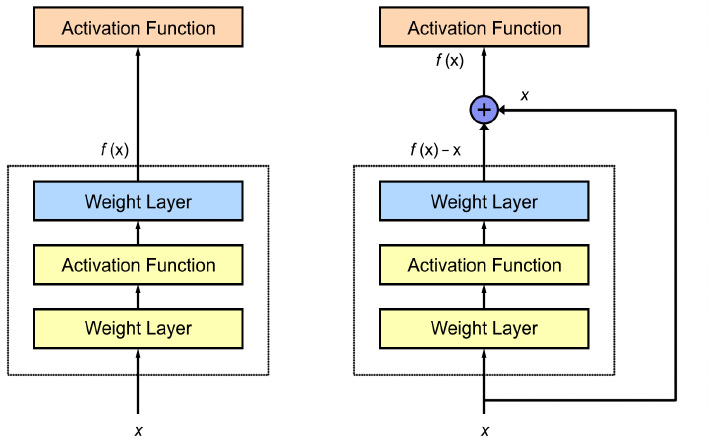
Figure 5. Residual network architecture used in racial